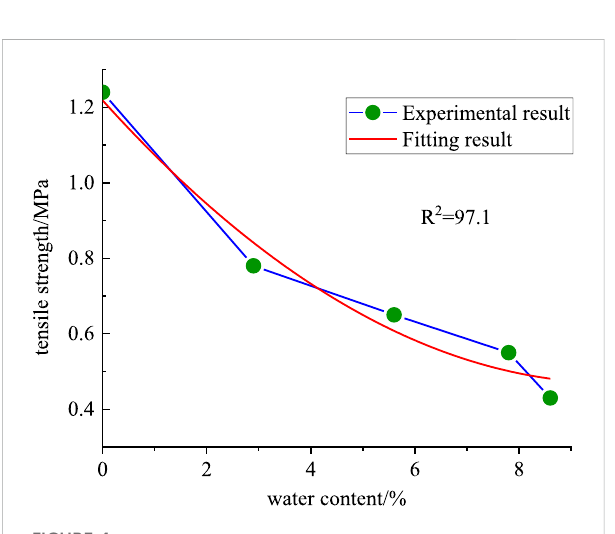
FIGURE 4 In fl uence of water content on tensile strength of red sandstone in the Brazilian splitting test.